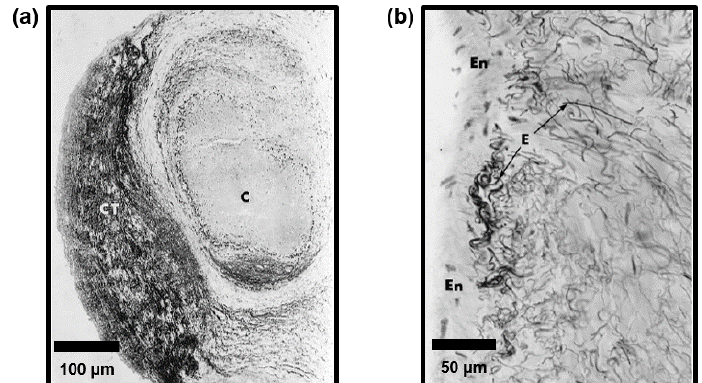
Figure 3. ( a ) A micrograph of a cross section of the chordae tendineae showing the collagen core (C) and the connective tissues (CT). ( b ) Within the connective tissue, a disorganized network of elastin fibers (E) and endothelium (En) exists (images from Millington-Sanders et al. [22] with permission from Wiley Global).